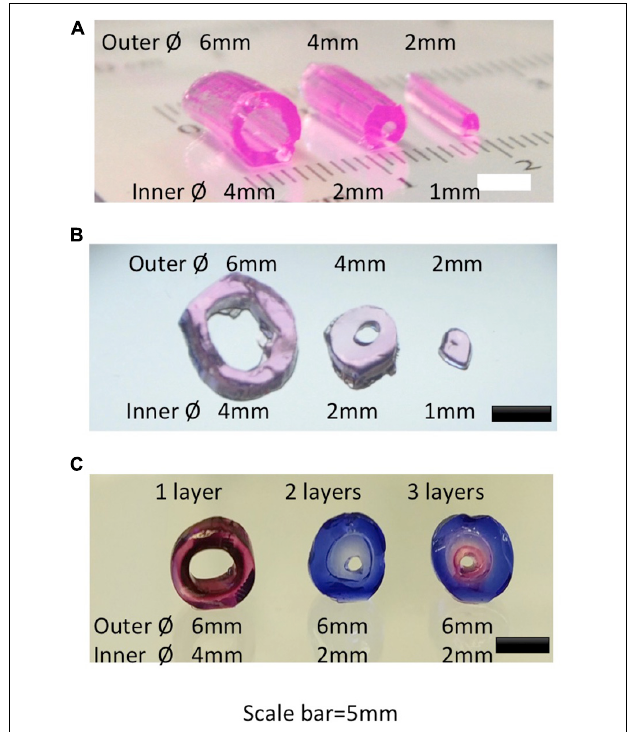
FIGURE 3 | Gross view and microscopic view of hydrogel constructs created with different diameters and layers. (A) Gross view of single vessel hydrogels with different diameters. (B) Cross view of single vessel hydrogels in panel (A) . (C) Cross view of single vessel structure with different layers of